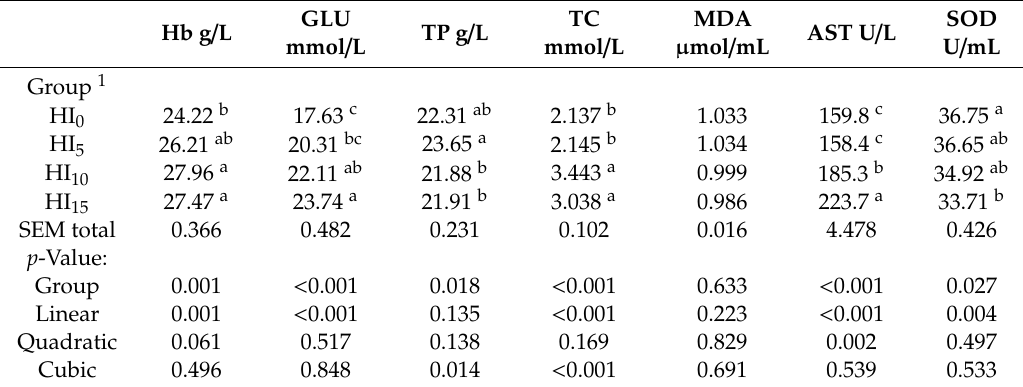
Table 4. Haematological and biochemical blood parameters of turkeys.